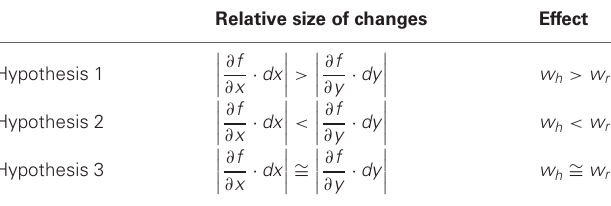
Table 1 | Mathematical summary of the three